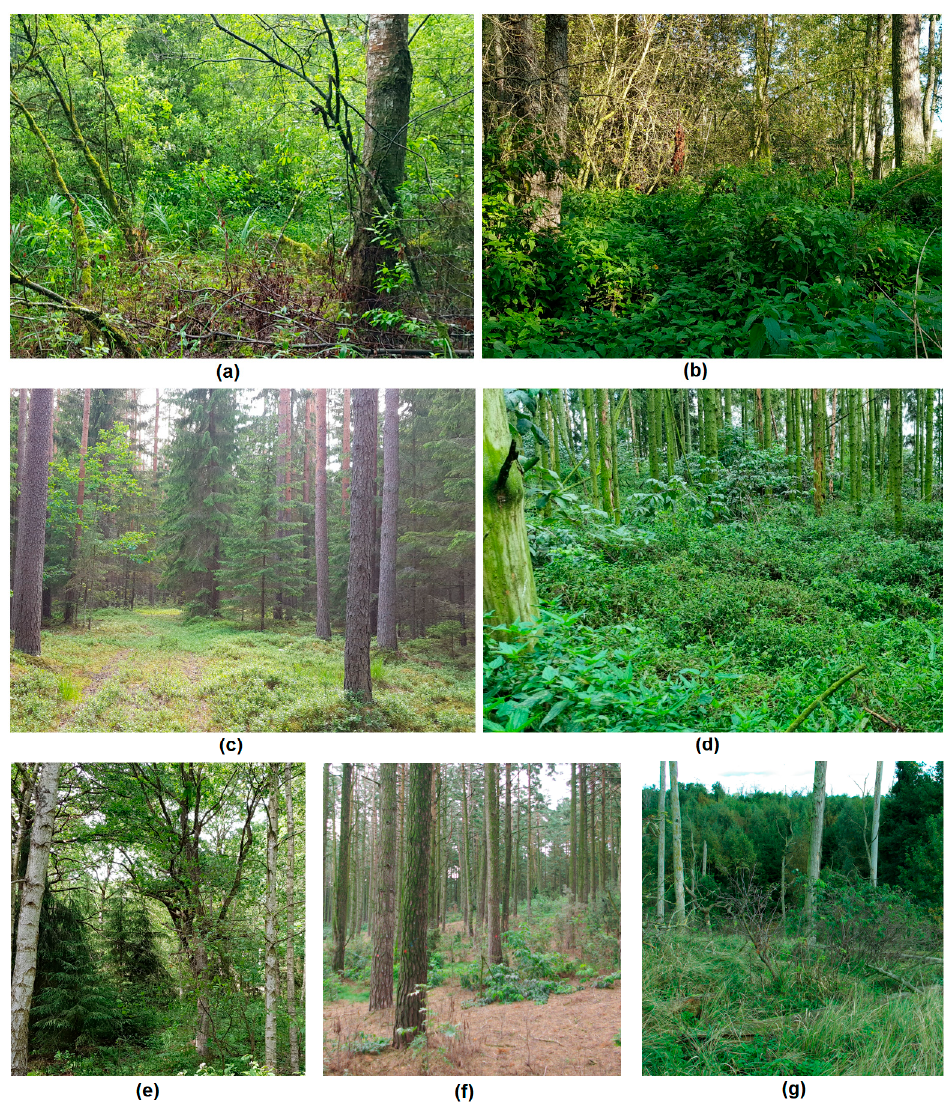
Figure 2. Investigated habitats: ( a )—control zone of Lukštas in 2019; ( b )—active zone of Lukštas, 2019; ( c )—control zone of Naudži ū nai in 2019; ( d )—active zone of Naudži ū nai in 2022; ( e )—control zone of Juodkrant ė in 2018; ( f )—active zone of Juodkrant ė in 2011; ( g )—abandoned nesting zone of Juodkrant ė in 2013.